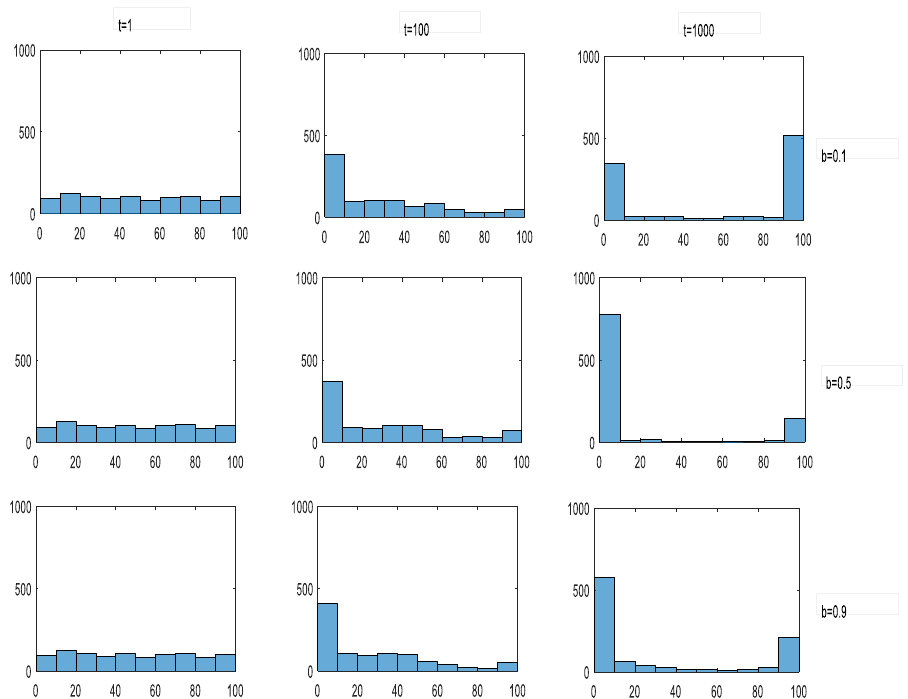
Figure 7. The evolution dynamic of reputation. Note: α = 0.01, r = 0.3, u = 0.3 and each row is b = 0.1, b = 0.5, b = 0.9 respectively.